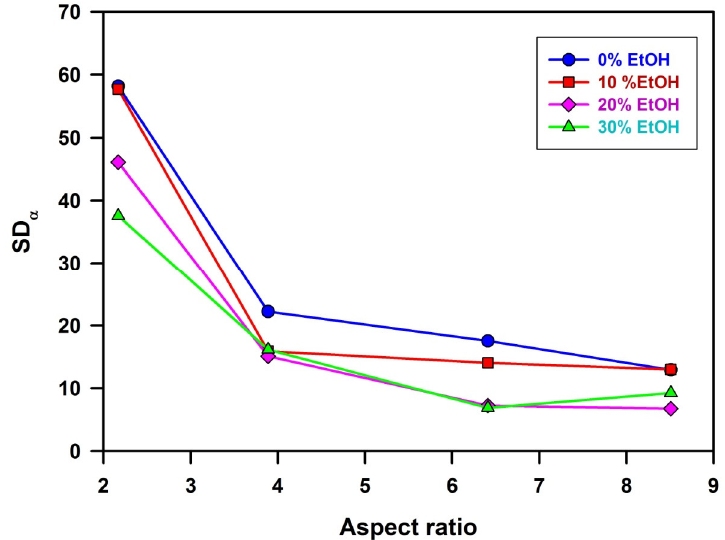
Figure 5. Plots of SD α as a function of AR for assemblies prepared from suspensions of P(S/PGL) microspheroids in water and water/ethanol media. Lines in the plots do not have any other meaning but are just to guide eyes.